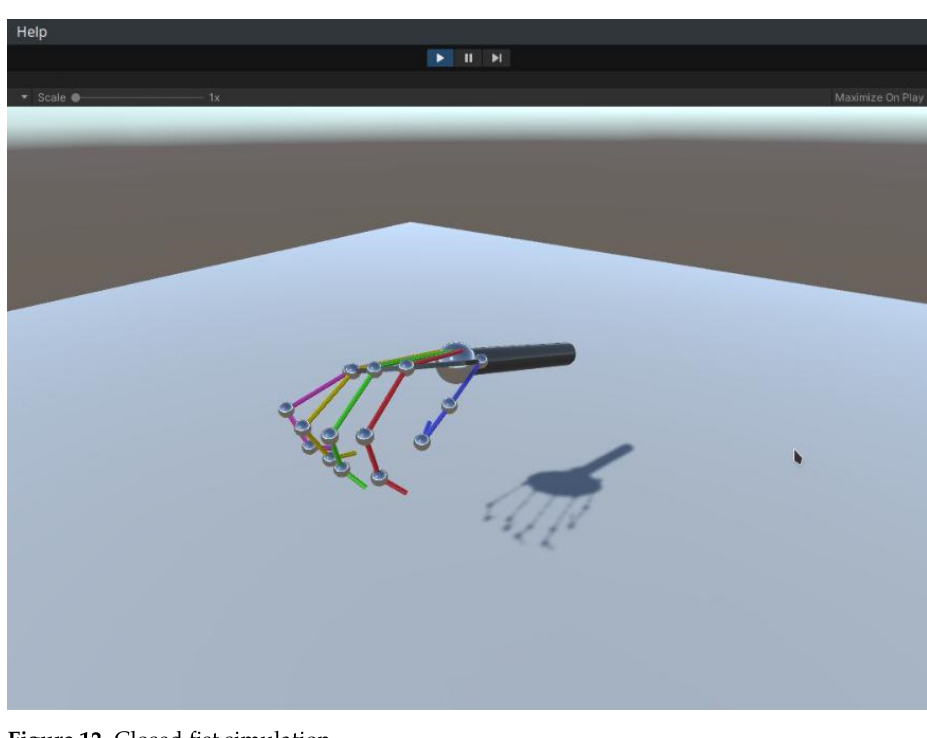
Figure 12. Closed fist simulation.